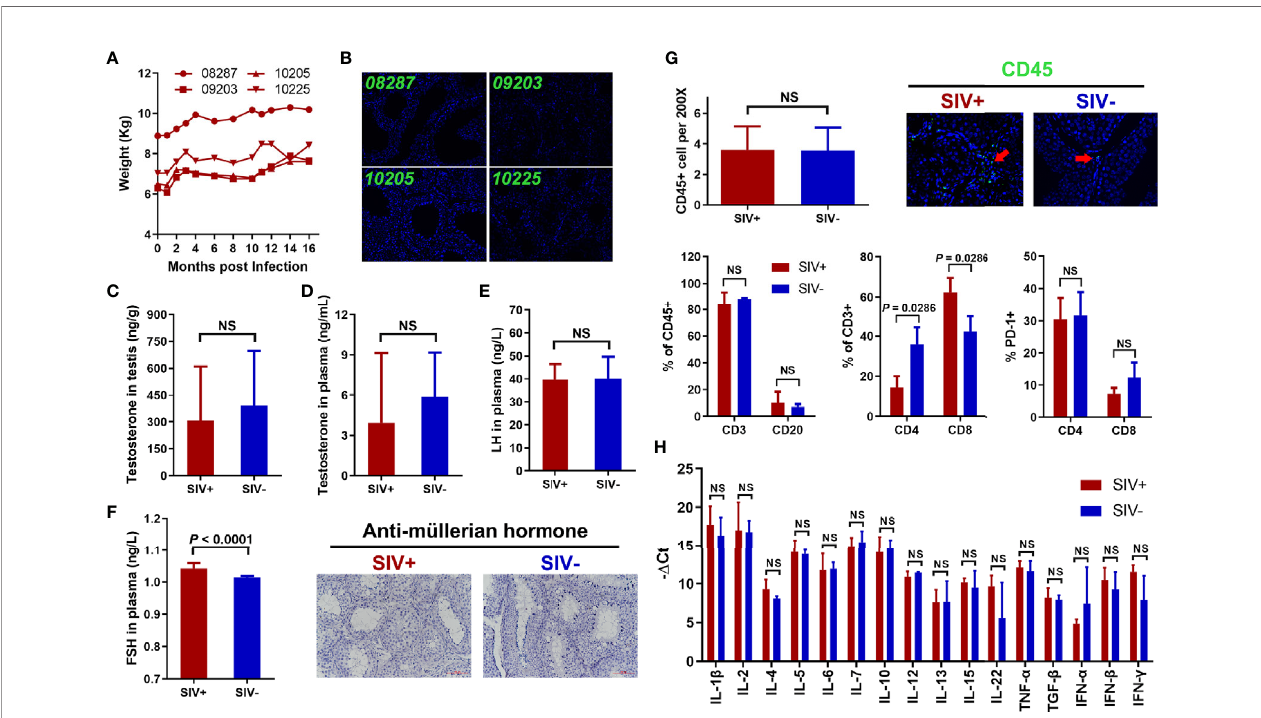
FIGURE 2 | Veri fi cation of hypotheses for spermatogenic dysfunction in NPMs with long-term SIVmac239 infection. (A) Changes in body weight during SIV infection; (B) Immunological staining of p27 in testicular tissues; (C) Concentration of testosterone in testis; (D) Concentration of testosterone in plasma; (E) Concentration of LH in plasma; (F) Concentration of FSH in plasma and immunological staining of AMH; (G) Immune cell count and phenotype in testicular tissue; (H) Expression levels of cytokines in testicular tissue. NS, no statistic signi fi